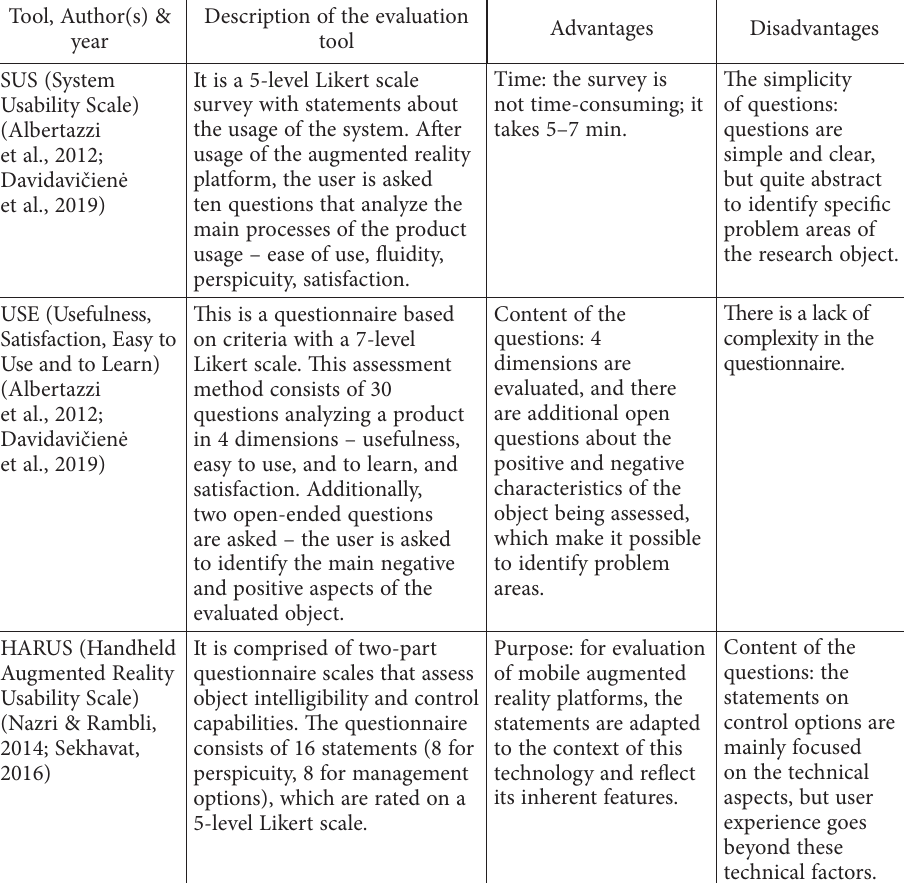
Table 1. Augmented reality user experience evaluation tools (source: created by the authors) Tool, Author(s) &